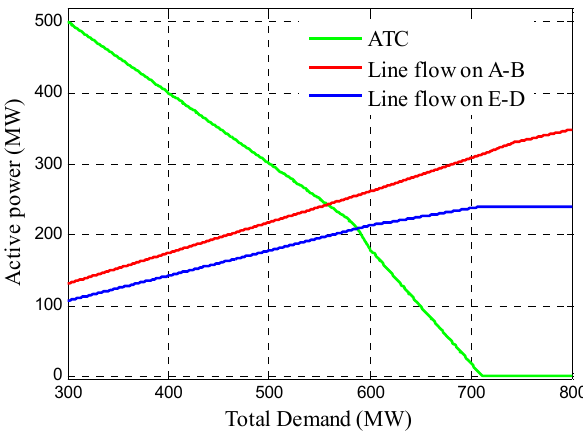
Figure 3. ATC and line flow under different demand level.